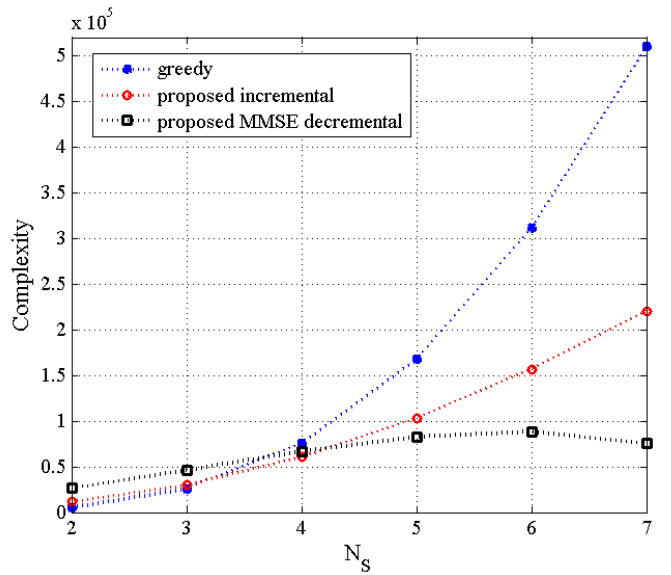
Figure 1. The complexity of the proposed transmit antenna subset (TAS) selection algorithms as a function of N S for ( 8, N S , K ) multiuser space–time line code (MU–STLC) system with N S = K